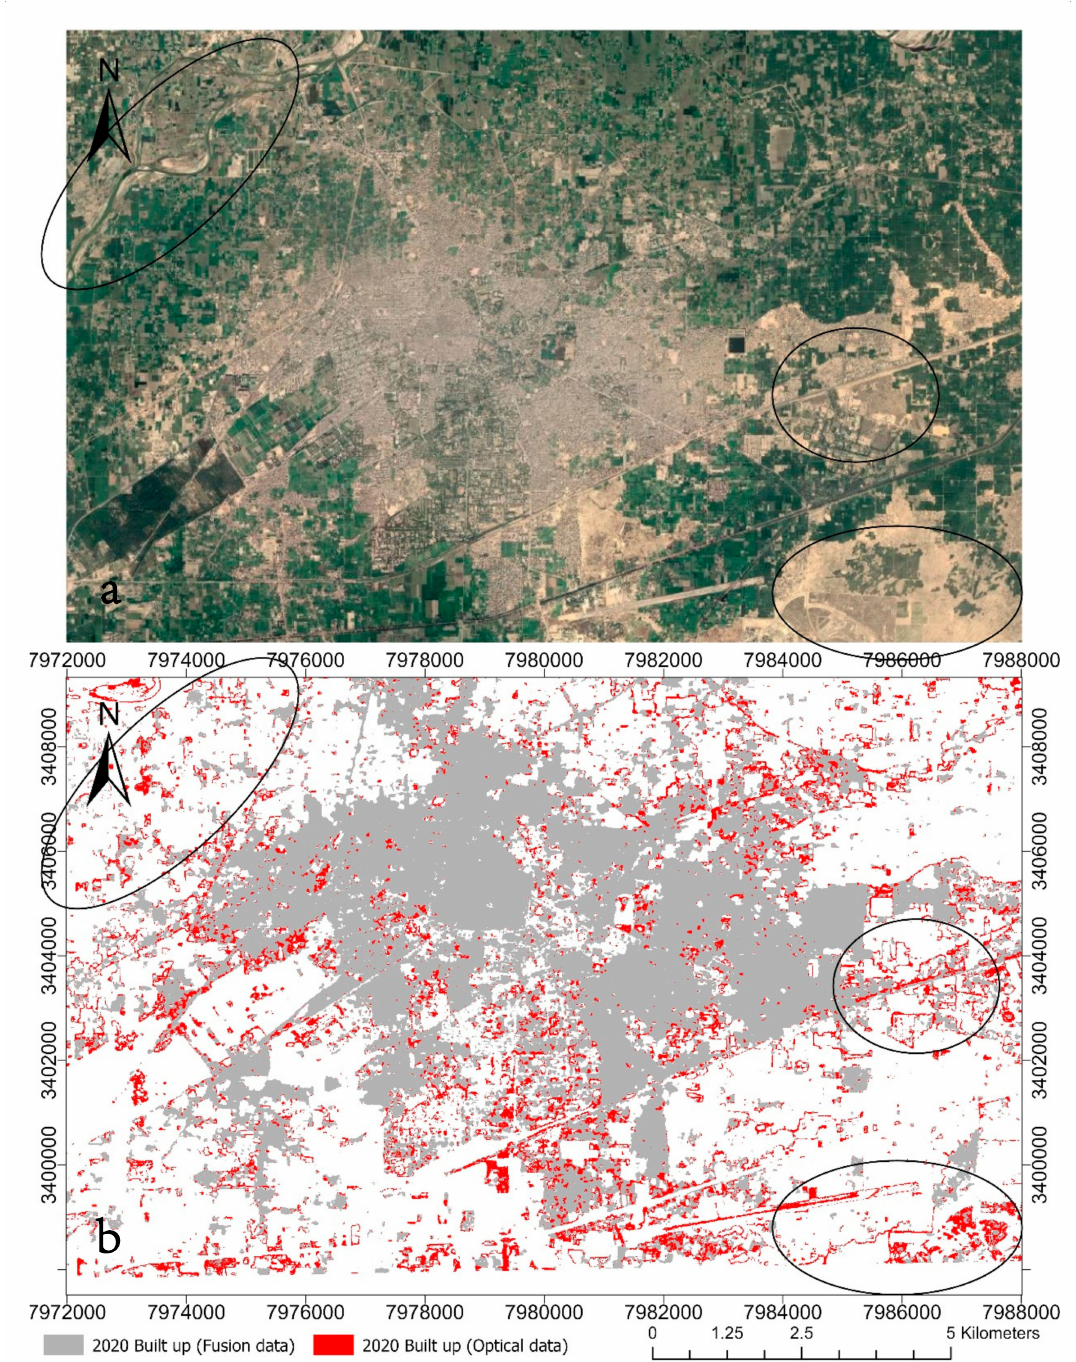
Figure 7. ( a ) The above figure is a true-color composite image from Google Earth Pro, for reference. ( b ) The lower figure is a barren surface around Bahawalpur that is misclassified as built-up by optical